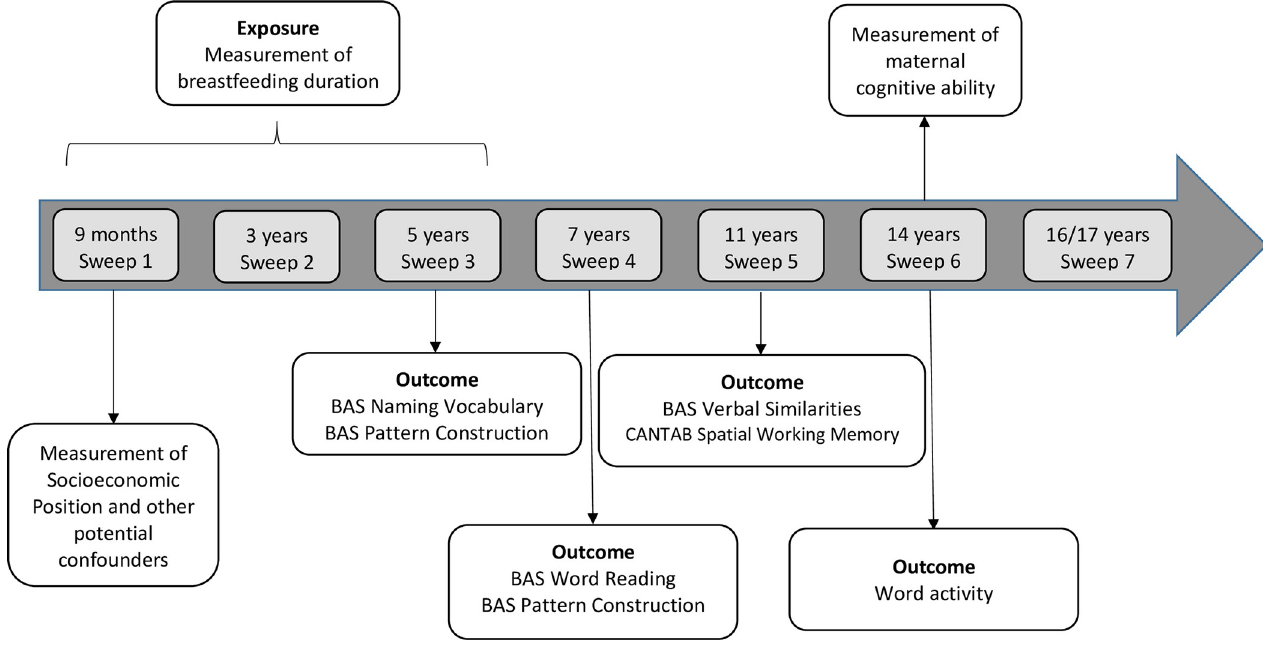
Fig 1. Association between breastfeeding duration and cognitive development among children from the UK Millennium Cohort Study.